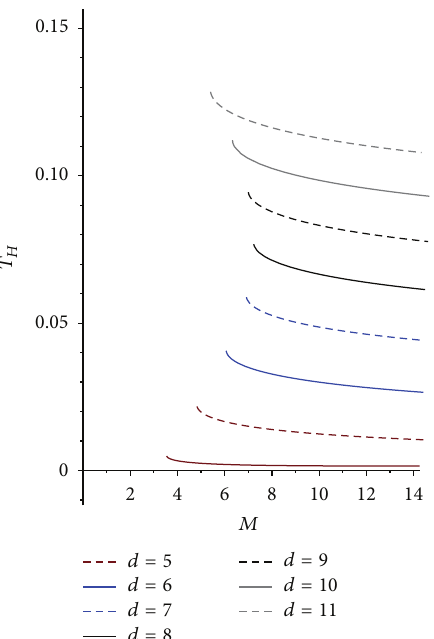
Figure 1: Hawking temperature for different amount of charges in presence of GUP.